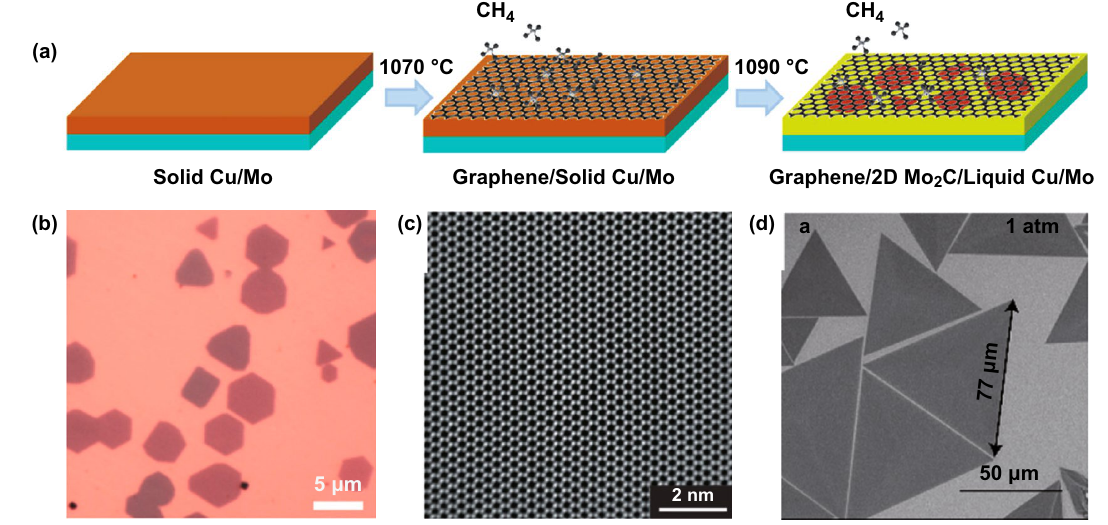
Fig. 7 Preparation of TMCs by chemical vapor deposition. a Mechanism of Mo 2 C growth, where the Cu foil is located on the surface of Mo foil. Reproduced with permission from Ref. [95]. Copyright 2017, American Chemical Society. b Formation of Mo 2 C flakes under graphene under high temperature. Reproduced with permission from Ref. [95]. Copyright 2017, American Chemical Society. c Atomic pattern of Mo 2 C by high resolution TEM. Reproduced with permission from Ref. [90]. Copyright 2015, Springer Nature. d SEM image of VC flakes. Reproduced with permission from Ref. [96]. Copyright 2020,